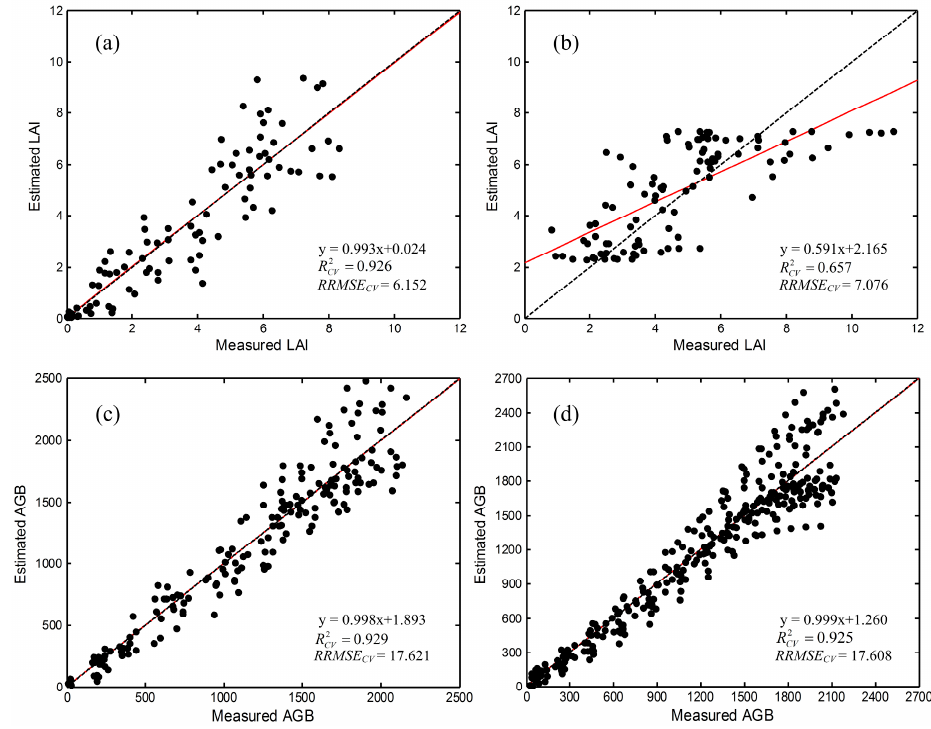
Figure 4. Relationships between measured rice leaf area index (m 2 /m 2 ) and dry aboveground biomass (g/m 2 ) at different rice growth stages with VIs. ( a ) Before heading LAI estimation using EVI2-BPNN regression; ( b ) after heading LAI estimation using NDVI-SVM regression; ( c ) all-growth stage AGB estimation using daily cumulative NDVI and based on the quadratic polynomial fit function; ( d ) all-growth stage AGB estimation using 10-day composite data and based on the cumulative NDVI quadratic polynomial fit function. The black dash lines are the 45° lines, and the red solid lines are the linear regression trend lines.